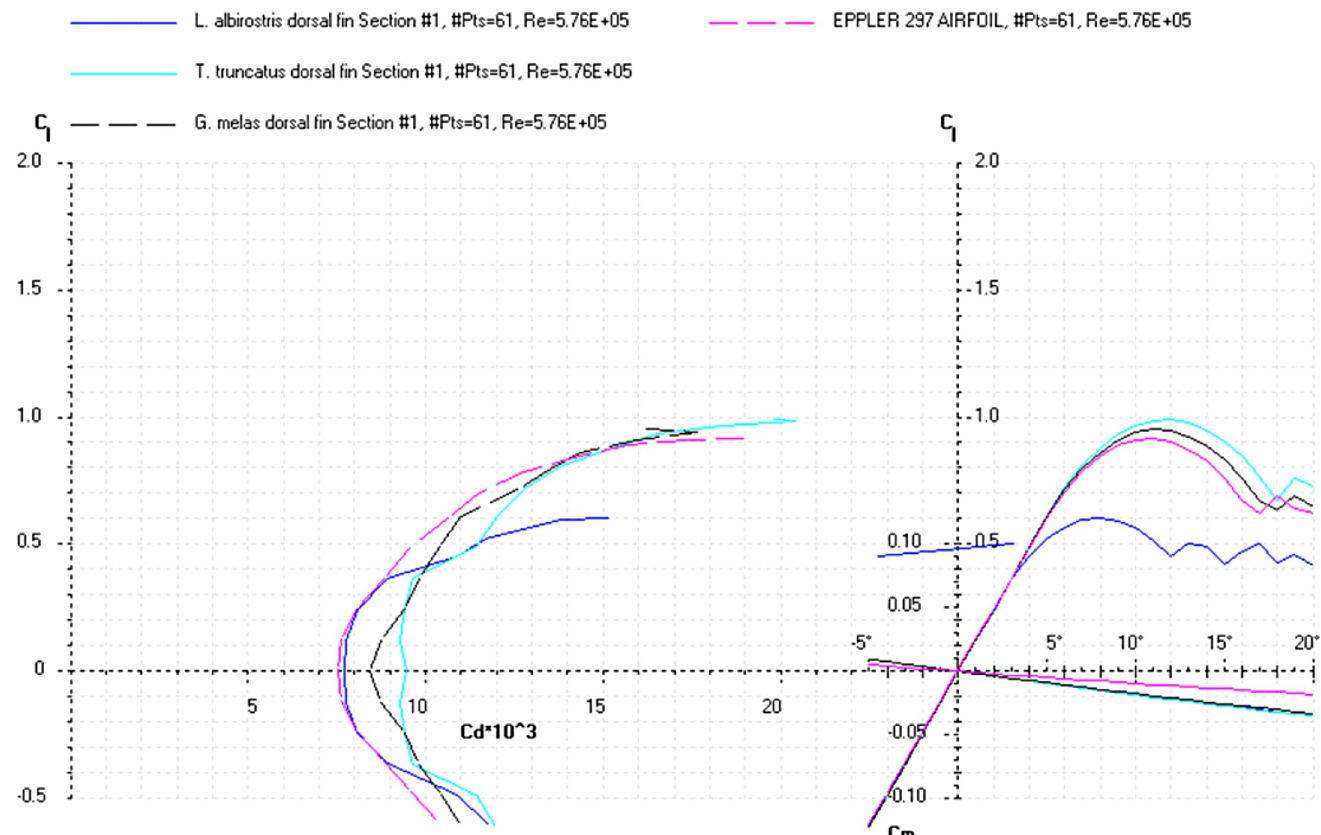
Fig 13. Drag polar diagram of lift CL vs drag Cd. Calculated for the cross-sections taken at the base of the dorsal fin of the L . albirostris , T . truncatus , G . melas and Eppler 297 airfoil at the averaged Re 5.76E+05 for the fin cross-sections (Table 9).